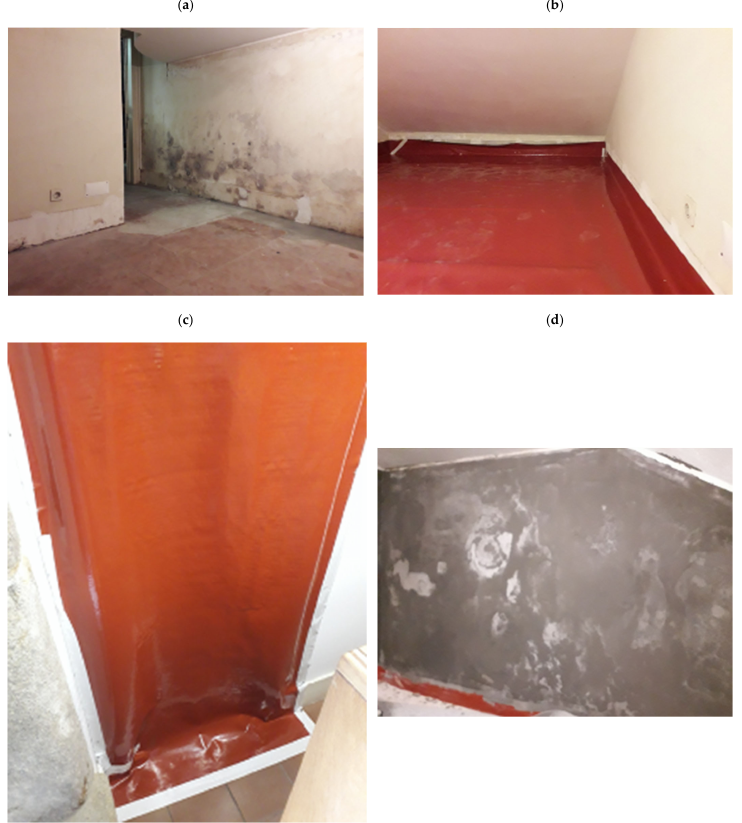
Figure 4. A sequence of works carried out. ( a ) Initial appearance before the execution of the tasks; ( b ) barrier membrane application; ( c ) sealing of the outer compartment door; ( d ) application of mor ‐ tar to the compartment walls.